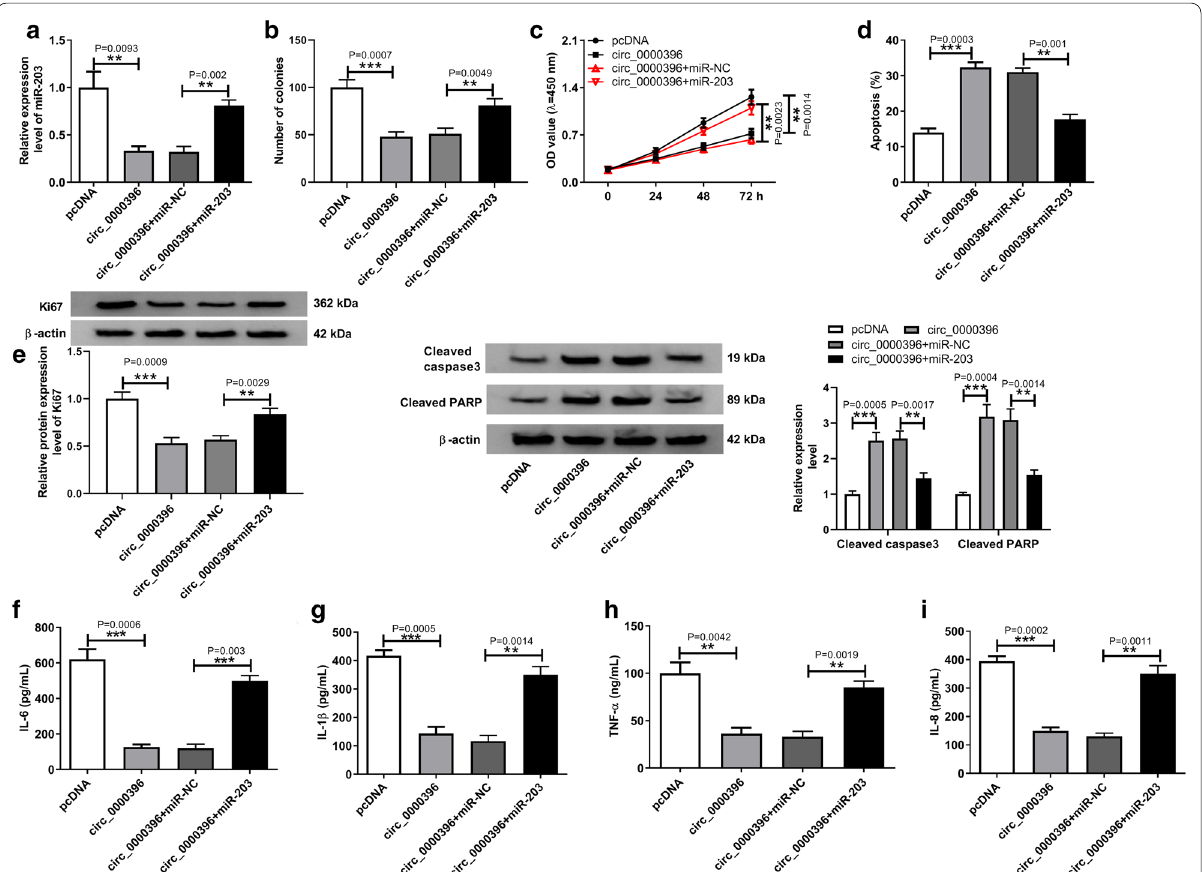
Fig. 4 Circ_0000396 affects the growth and inflammation of RASFs by binding to miR-203. RASFs were transfected with pcDNA, circ_0000396, circ_0000396 miR-NC, circ_0000396 miR-203. After transfection, a the expression of miR-203 was measured by qRT-PCR; b , c RASF proliferation + + was analyzed by colony formation assay and CCK-8 assay, respectively; d the apoptosis of RASFs was measured by flow cytometry; e the expression of Ki67, cleaved caspase3 and cleaved PARP expression in RASFs was detected using western blot; f – i The level of inflammatory cytokines IL-6, IL-1β, IL-8 and TNF-α in RASFs was detected by ELISA assay. * p < 0.05, ** p < 0.01, *** p < 0.001, **** p < 0.0001